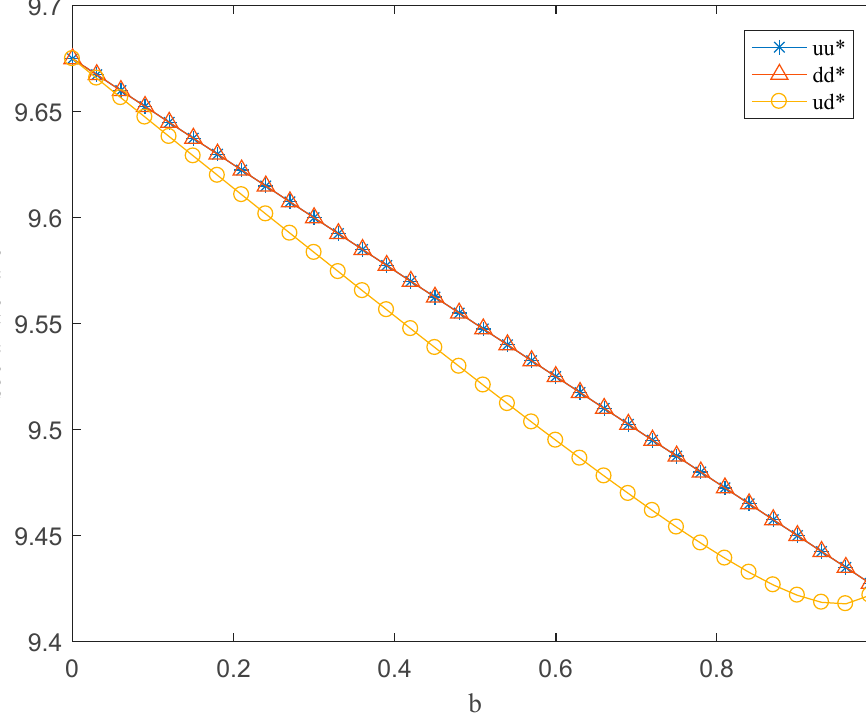
Figure 3. The total social welfare under different situations.